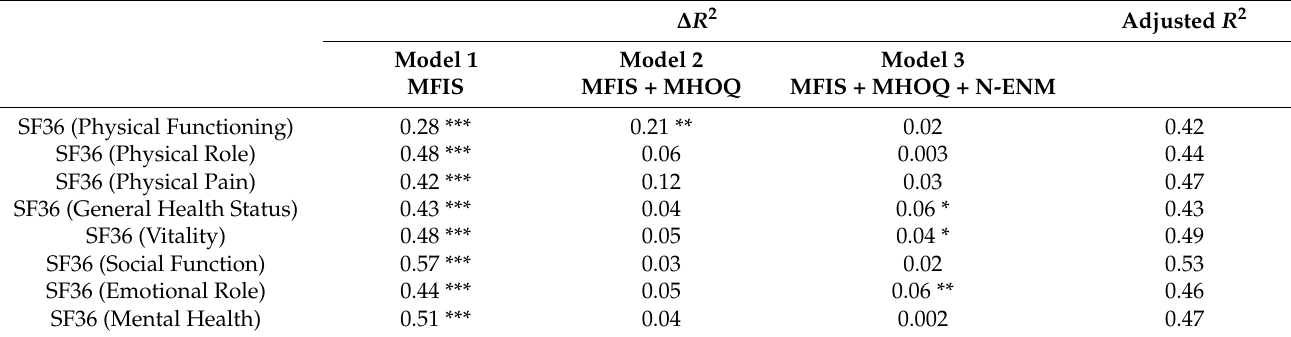
Table 6. Increment of explained variance in the dimensions of the SF36 scale as a function of including fatigue (MFIS), hand satisfaction (MHOQ), and number of neuromuscular diseases (N-ENM) variables in successive models. Adjusted R 2 shows total variance explained by all the predictors in the last